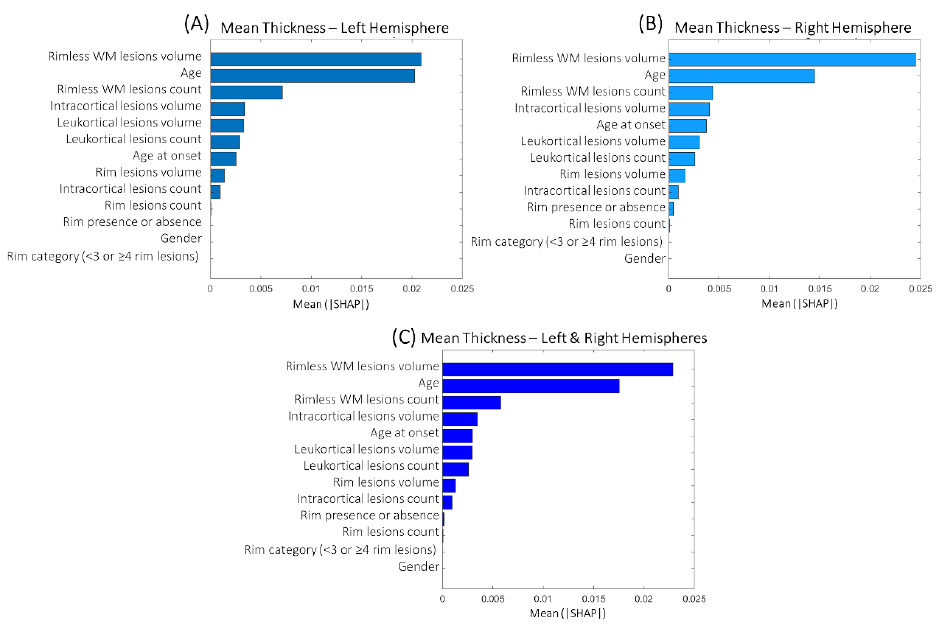
Figure 4. Mean feature importance evaluated across 50 repetitions obtained when predicting cortical thickness in single hemispheres ( A , B ) and whole brain ( C ).